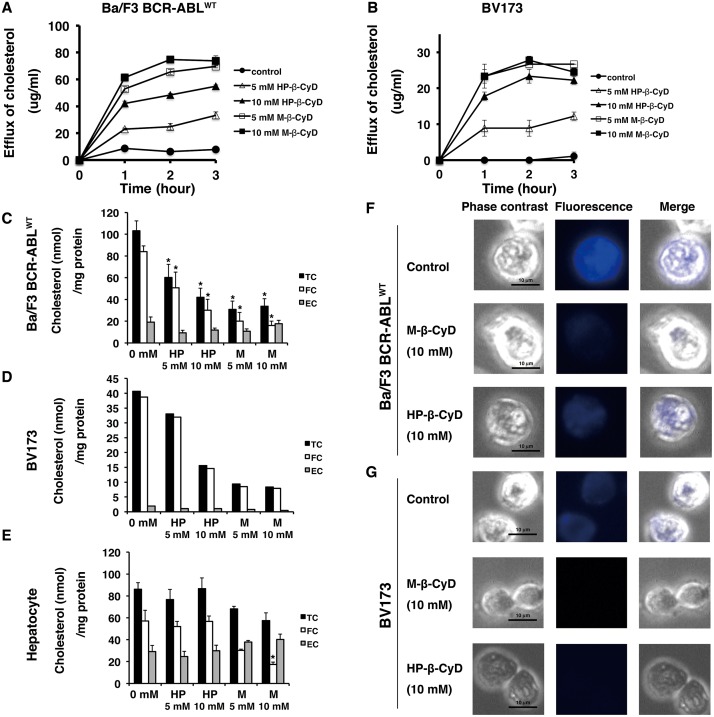
Disruption of cellular cholesterol homeostasis by β-CyDs.(A and B) Effect of β-CyDs on cholesterol efflux from Ba/F3 BCR-ABLWT and BV173 cells. Ba/F3 BCR-ABLWT cells (A) and BV173 cells (B) were incubated with β-CyDs (5 mM, 10 mM) for 1, 2, or 3 hours. Then the cholesterol concentration of the culture supernatants was determined. (●), control; (△), 5 mM HP-β-CyD; (▲), 10 mM HP-β-CyD; (□), 5 mM M-β-CyD; (■), 10 mM M-β-CyD. Data are the mean ± SD of three experiments. (C–E) Measurement of the intracellular cholesterol content of β-CyD-treated cells. Ba/F3 BCR-ABLWT (C), BV173 (D), and hepatocytes (E) were incubated with vehicle, HP-β-CyD (5 mM, 10 mM), or M-β-CyD (5 mM, 10 mM), respectively. After 1 hour, cellular lipids were extracted, and cholesterol contents were determined. HP, HP-β-CyD; M, M-β-CyD; TC, total cholesterol; FC, free cholesterol; EC, esterified cholesterol. (F and G) Images of filipin staining for Ba/F3 BCR-ABLWT (F) or BV173 cells (G) treated with 10 mM β-CyDs for 1 hour are shown. Scale bar: 10 μm.